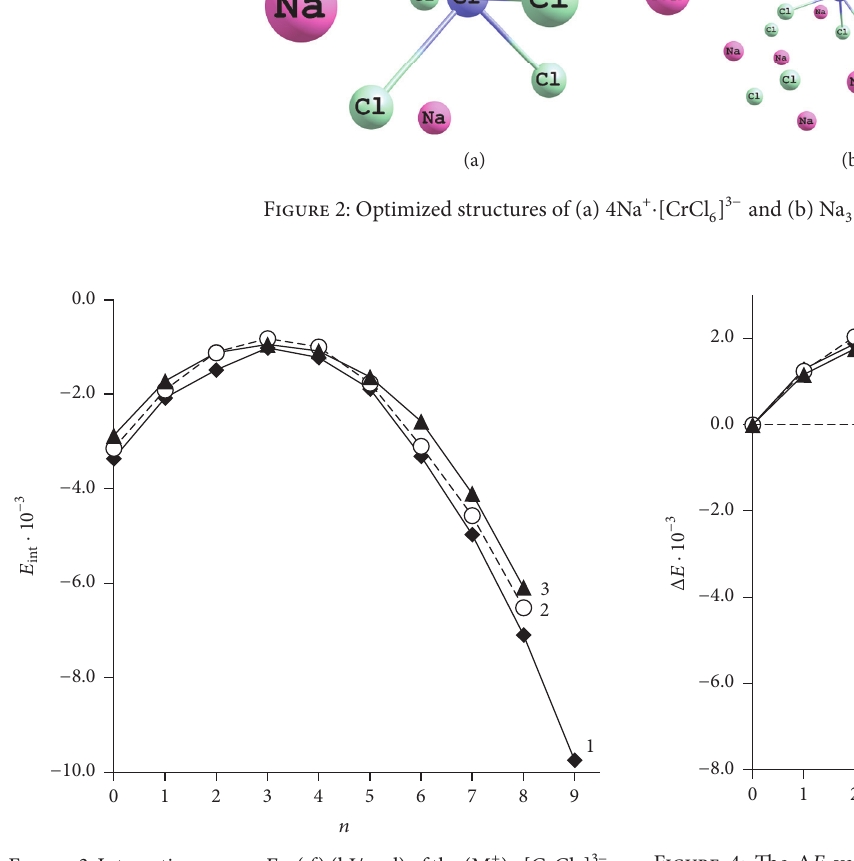
Figure3:Interactionenergy 𝐸 int (𝑓) (kJ/mol)ofthe(M + ) 𝑛 ⋅ [CrCl 6 ] 3− species in systems II M 3 CrCl 6 + 18MCl versus the number of OS cations for (1) Na, (2) K, and (3) Cs.